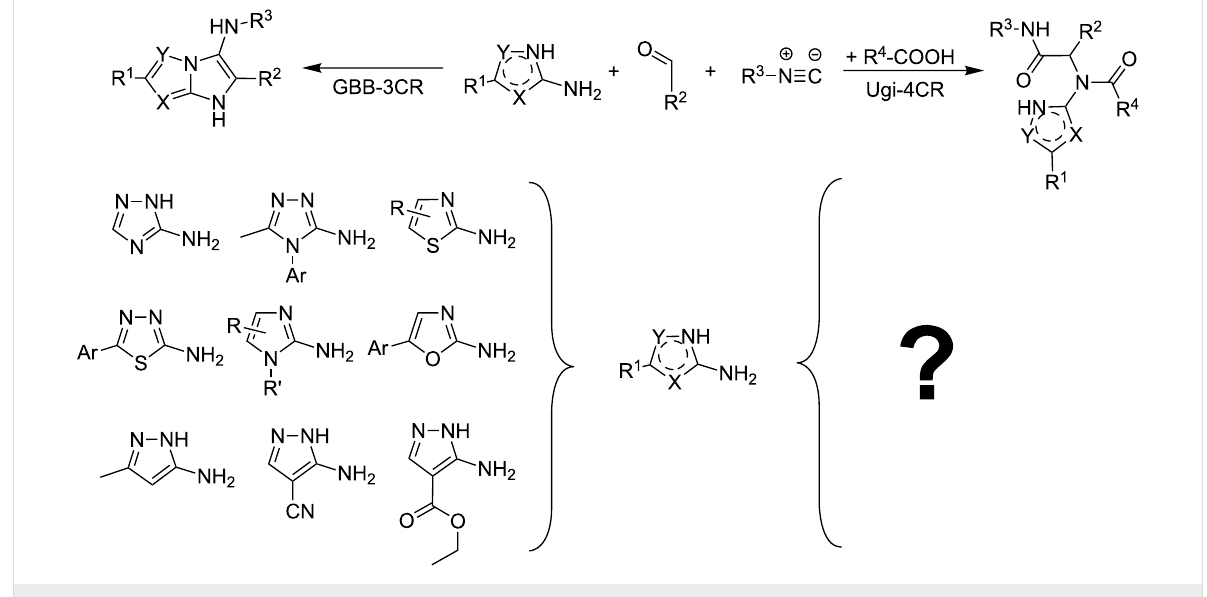
Scheme 1: Aminoazoles in GBB-3CR and